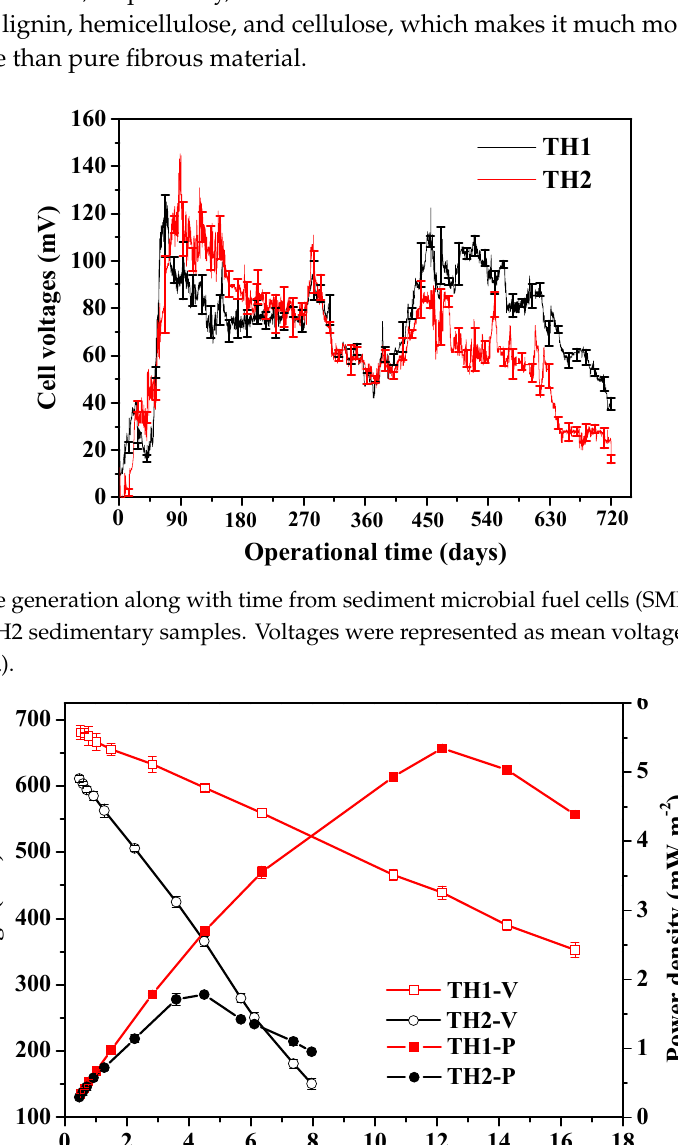
. Figure 3. Removal efficiencies of total organic carbon (TOC) in TH1 and TH2 sediments by control and SMFCs during the 700 days of incubation.